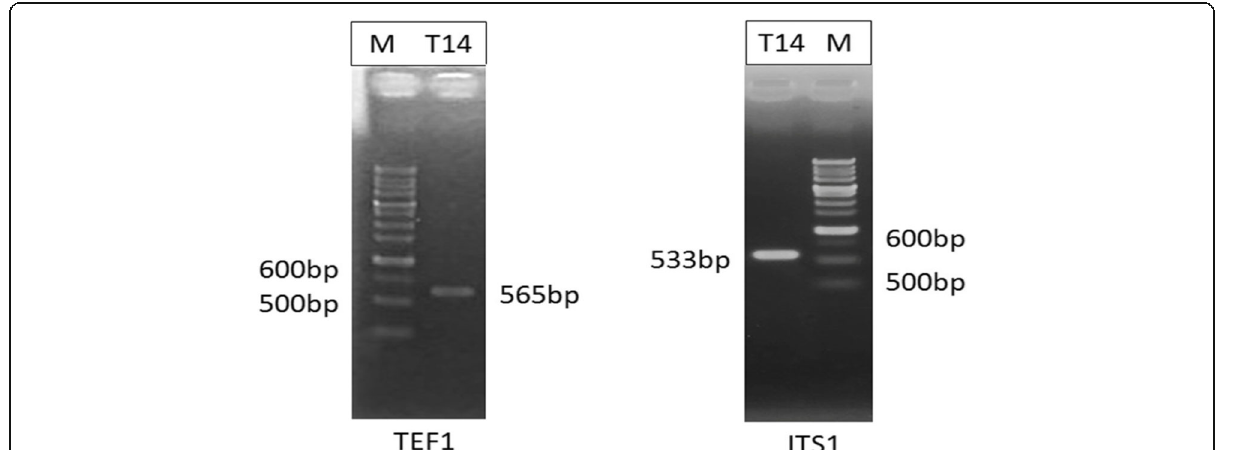
Fig. 6 Agarose gel image of PCR-amplified (TEF1 and ITS1) genes regions of T14